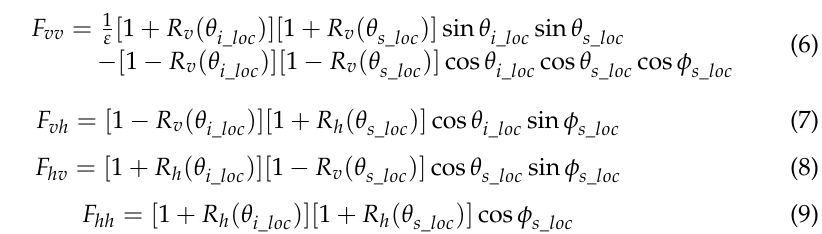
where ˆ ˆ represent the global horizontal and vertical polarization vectors, ˆ represent the horizontal and vertical polarization vectors in the local and coordinate system. , F represent the scattering polarization factors in the lo- cal coordinate system, which can be expressed as